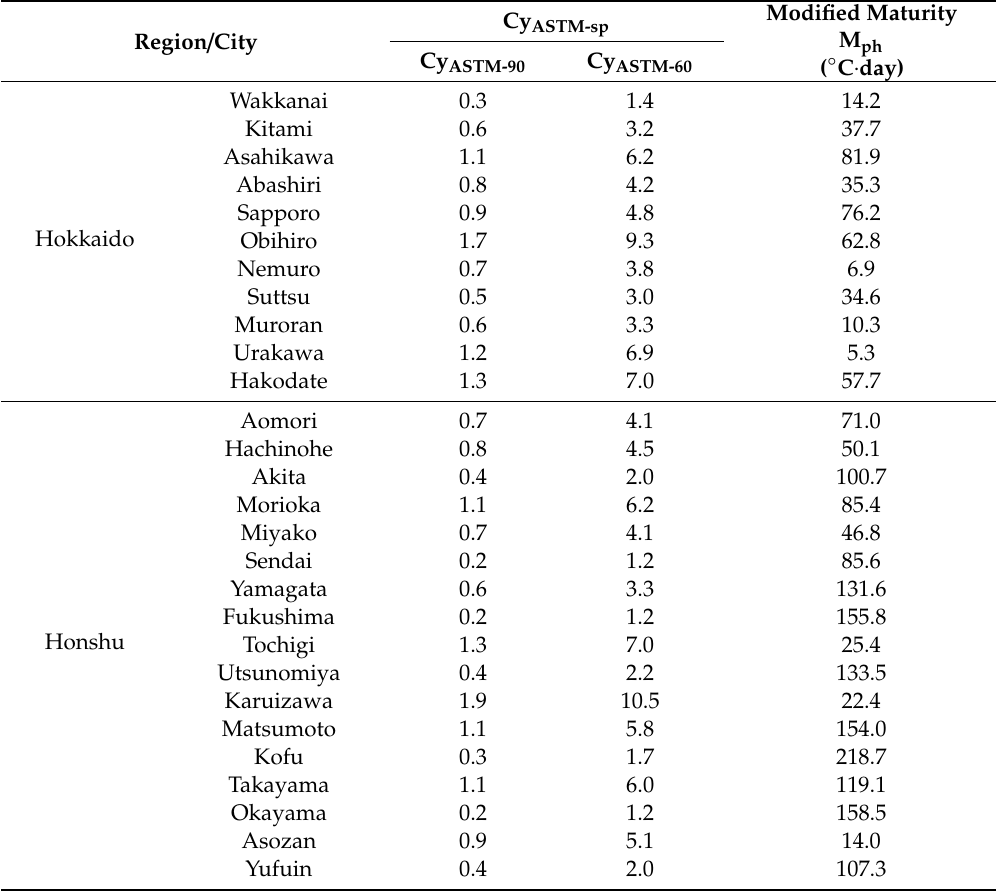
Table 3. Cy ASTM-sp and modified maturity values of each region in